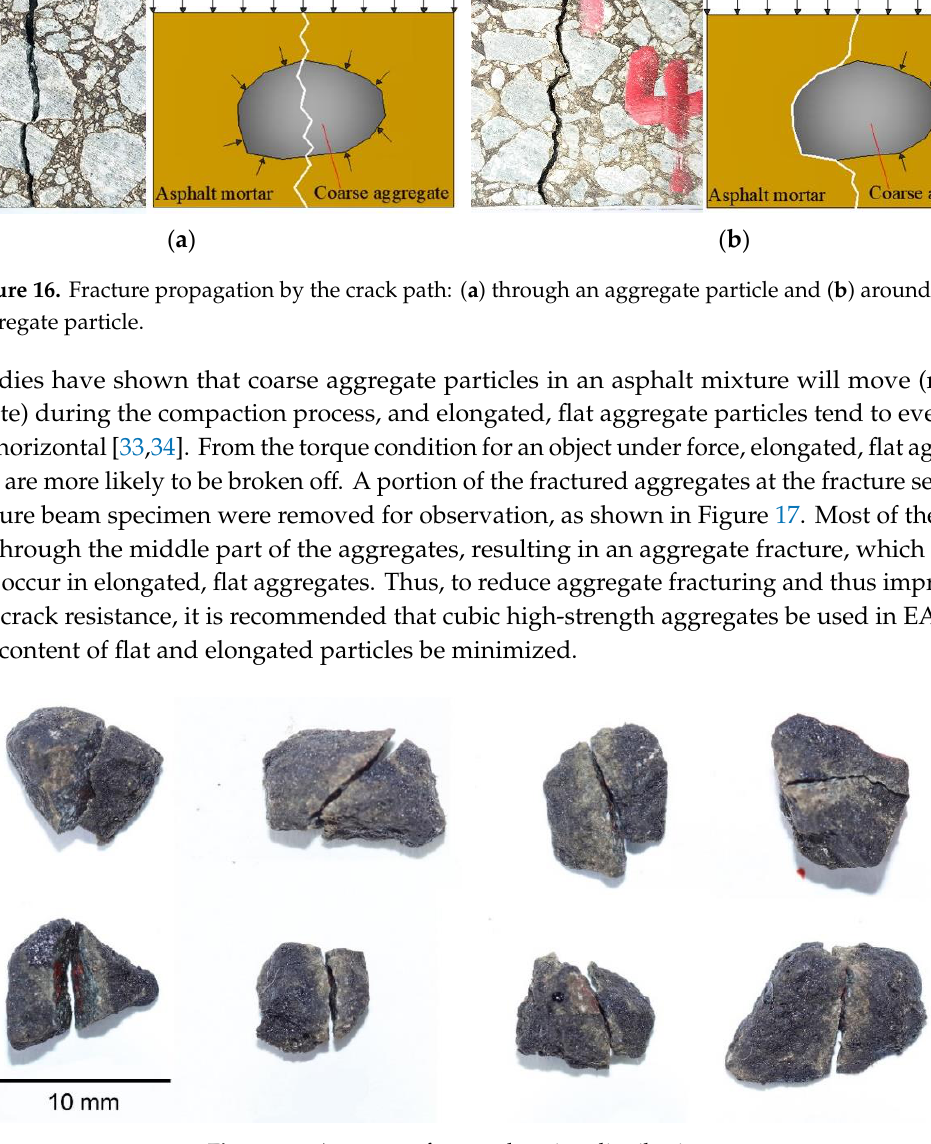
Figure 17. Aggregate fracture location distribution.